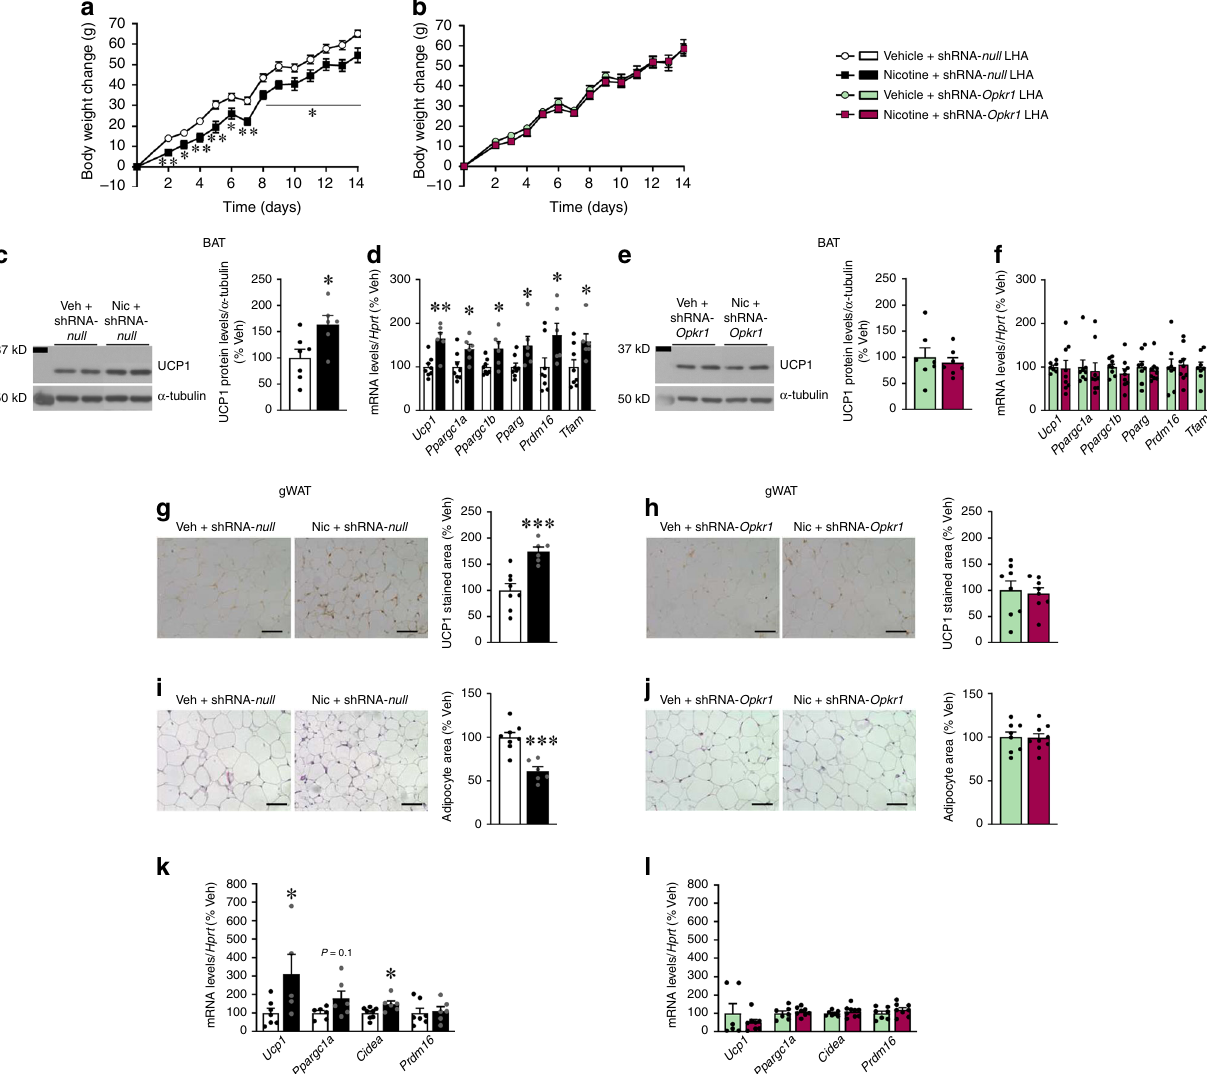
Fig. 5 Effect of LHA Opkr1 knockdown on nicotine ’ s effect on BAT and WAT. a – b Body weight (vehicle + shRNA- null LHA n = 8, nicotine + shRNA- null LHA n = 6, vehicle + shRNA- Opkr1 LHA n = 8, nicotine + shRNA- Opkr1 LHA n = 9 rats). c – e Representative images (left panels) and protein levels of UCP1 in the BAT (right panels) (vehicle + shRNA- null LHA n = 7, nicotine + shRNA- null LHA n = 6, vehicle + shRNA- Opkr1 LHA n = 7, nicotine + shRNA- Opkr1 LHA n = 7 rats). d – f mRNA levels of thermogenic markers in the BAT (vehicle + shRNA- null LHA n = 8, nicotine + shRNA- null LHA n = 6, vehicle + shRNA- Opkr1 LHA n = 7, 8, 8, 8, 8, 8, nicotine + shRNA- Opkr1 LHA n = 9, 9, 9, 9, 9, 7 rats). g – h UCP1 staining (left panels 20 × , scale bar: 100 μ m) and UCP1 stained area (right panels) in gWAT (vehicle + shRNA- null LHA n = 8, nicotine + shRNA- null LHA n = 6, vehicle + shRNA- Opkr1 LHA n = 8, nicotine + shRNA- Opkr1 LHA n = 8 rats). i – j H&E staining (left panels 20×, scale bar: 100 μ m) and adipocyte area (right panels) in gWAT (vehicle + shRNA- null LHA n = 8, nicotine + shRNA- null LHA n = 6, vehicle + shRNA- Opkr1 LHA n = 8, nicotine + shRNA- Opkr1 LHA, n = 9 rats). k – l mRNA levels of thermogenic markers in the gWAT (vehicle + shRNA- null LHA n = 7, 6, 8, 7, nicotine + shRNA- null LHA n = 5, 6, 6, 6, vehicle + shRNA- Opkr1 LHA n = 6, 7, 7, 7, nicotine + shRNA- Opkr1 LHA n = 8, 8, 9, 8 rats) . of rats stereotaxically treated within the LHA with AAVs harboring a shRNA- null ( a , c , d , g , i and k ) or a shRNA against Opkr1 ( b , e , f , h , j and l ) and treated with vehicle or nicotine. Center values represent average; error bars represent SEM. Statistical signi fi cance was determined by two-sided t -Student; * P <0.05, ** P <0.01, *** P <0.001 vs. vehicle. In the panels c and e showing images of gels, all the bands for each picture come from the same gel but they have been spliced for clarity. Source data are provided as a Source Data fi